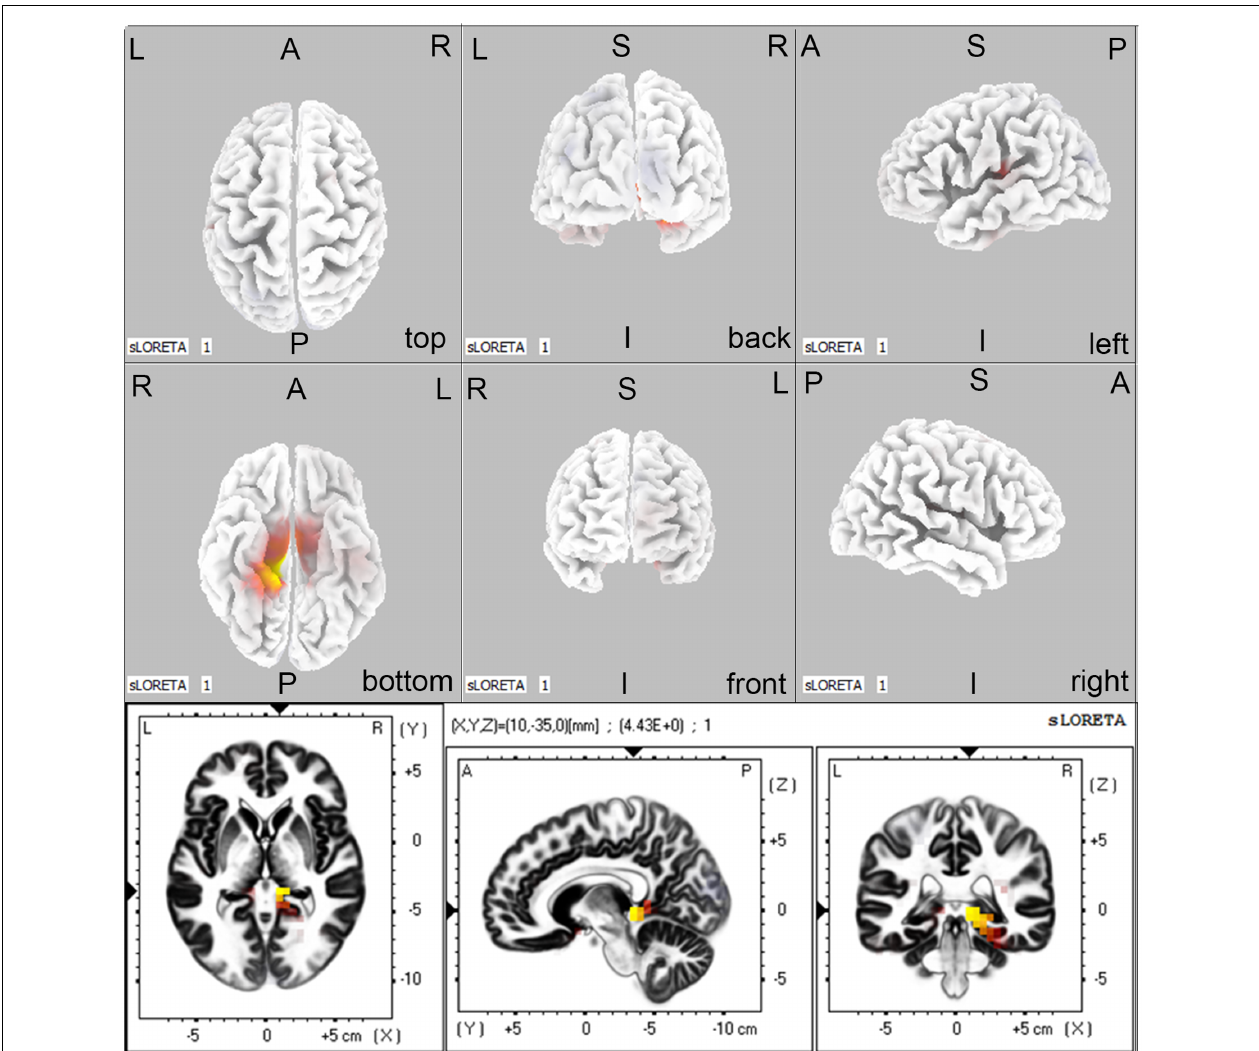
FIGURE 4 | The sLORETA images showing statistical differences between aMCI-APOE ε 4+ and aMCI-APOE ε 4– group (three dimensional-view and slice-view) during the P300 time range. The three slice-view images below located the maximal difference between aMCI-APOE ε 4+ and aMCI-APOE ε 4– group (MNI coordinates x , y , z = 10, –35, 0). Activation maxima are color coded in yellow. These images represent greater brain activation in the right PHG in APOE ε 4 carriers with respect to non-carriers in aMCI patients. Abbreviations: aMCI, amnestic mild cognitive impairment; APOE, apolipoprotein E; MNI, Montreal Neurological Institute; PHG, parahippocampal gyrus; sLORETA, standardized low-resolution brain electromagnetic tomography